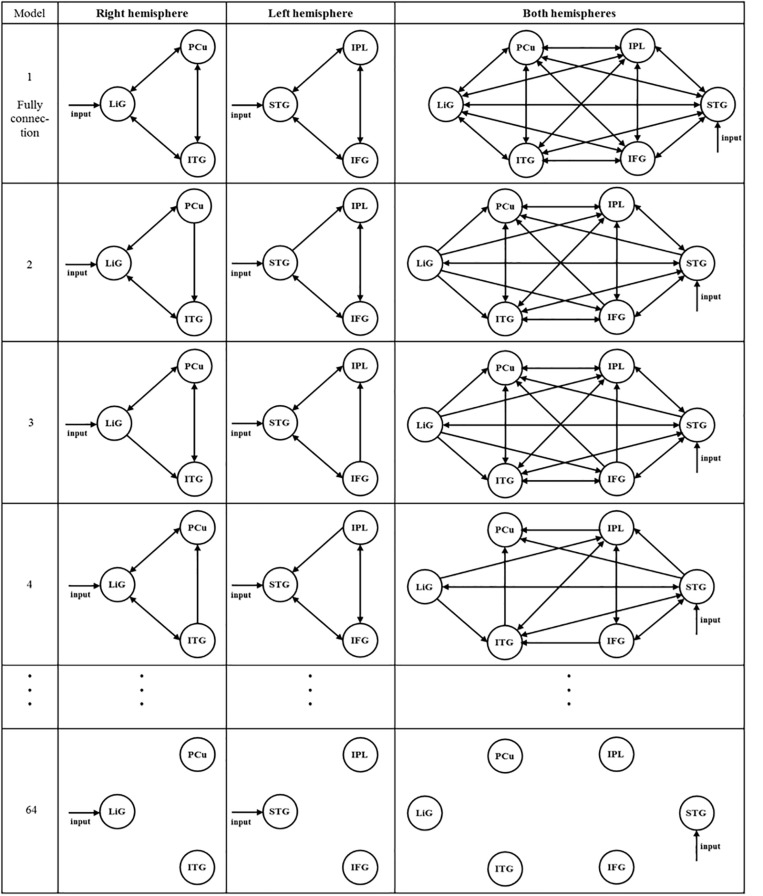
After selecting the driving input areas of the right, left, and both hemispheres, 64 models were established to analyze the connectivity between the areas of interest.